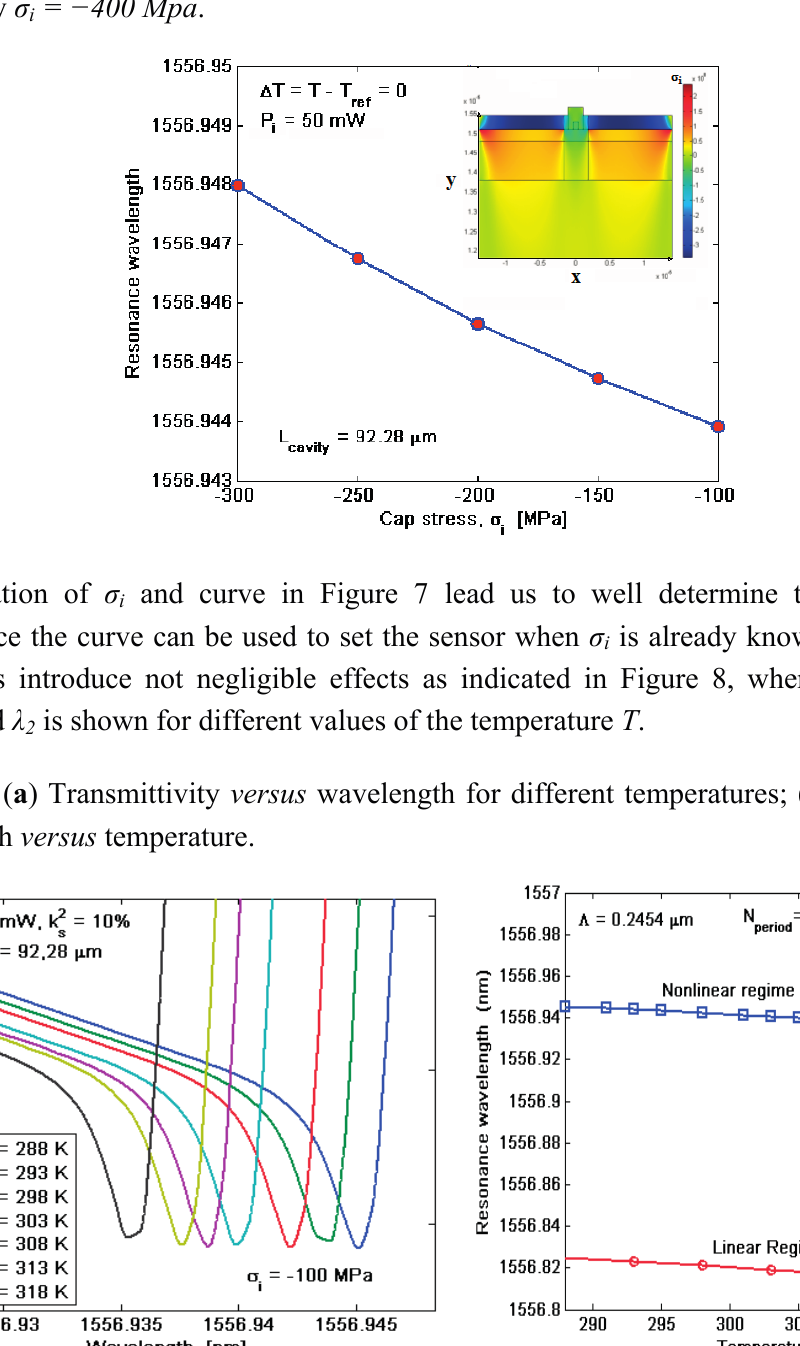
Figure 7. Resonance wavelength shift versus the cap layer stress; (inset) structure stress induced by σ = − 400 Mpa . i